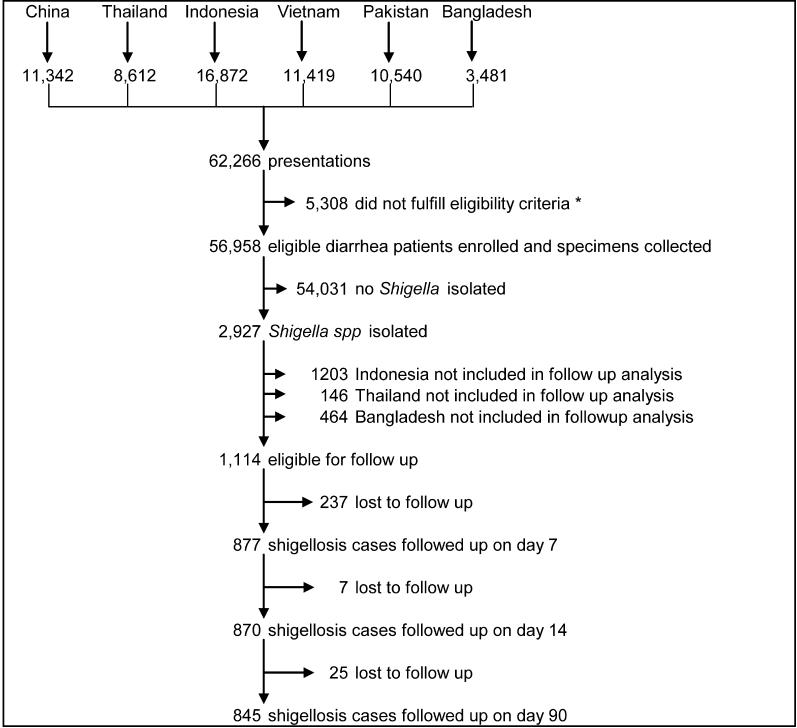
Assembly of Cases* Eligibility criteria: three or more bowel movements per 24 h or at least one loose stool with blood, and consent from patient or parent/guardian.